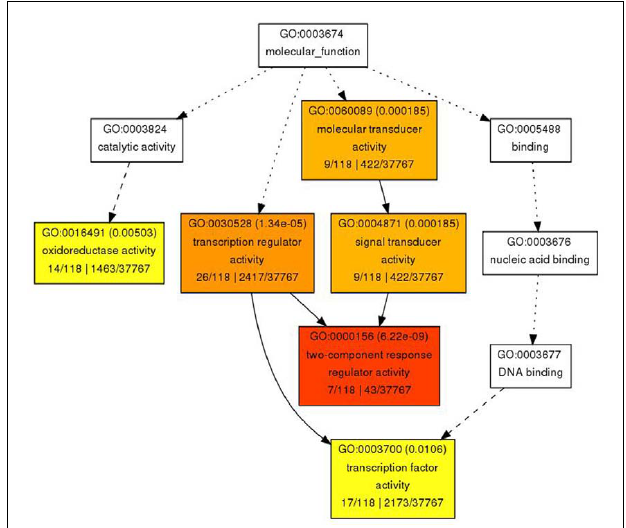
FIGURE 7 | Gene Ontology analysis for molecular function for genes with reduced expression in pan mutant inflorescence apices. Significantly enriched GO categories are shown in yellow, orange, and